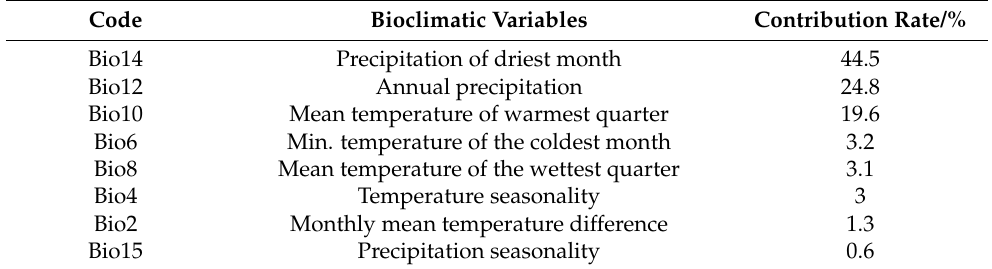
Table 1. The contribution rates of selected bioclimatic variables affecting the distribution of M. alternatus . Code